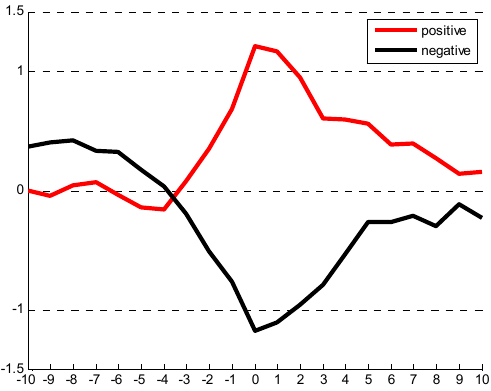
Figure 10. Composite of the EU index from a lag of − 10 to 10 days. A lag of 0 day denotes the peak phase. The red line denotes the positive phase and the black line is the negative phase.